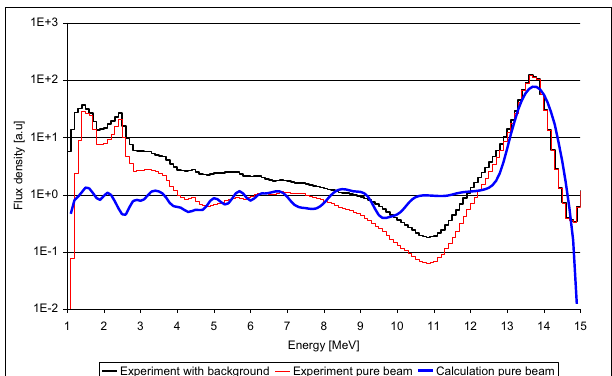
Figure 9. The room effect in the VSB